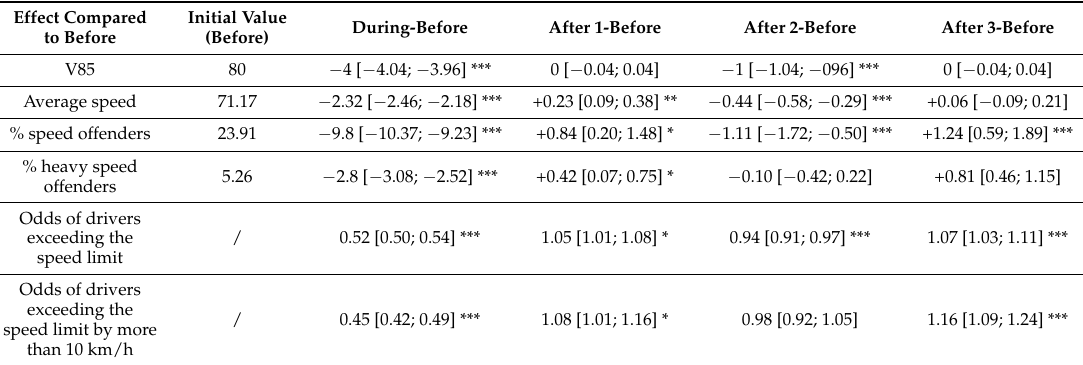
Table 5. Results of the overall effects at measurement point 1 in regional police unit